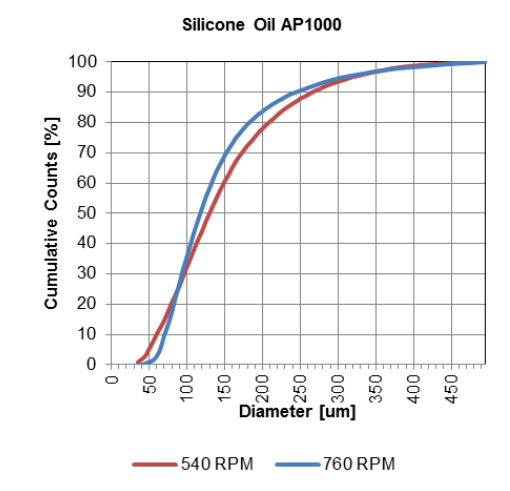
Fig. 7. Comparison of cumulative particle counts of stable dispersion of disintegrated Rhodosil Oil 47V50 under stirrer rate 540 rpm, and 760 rpm.